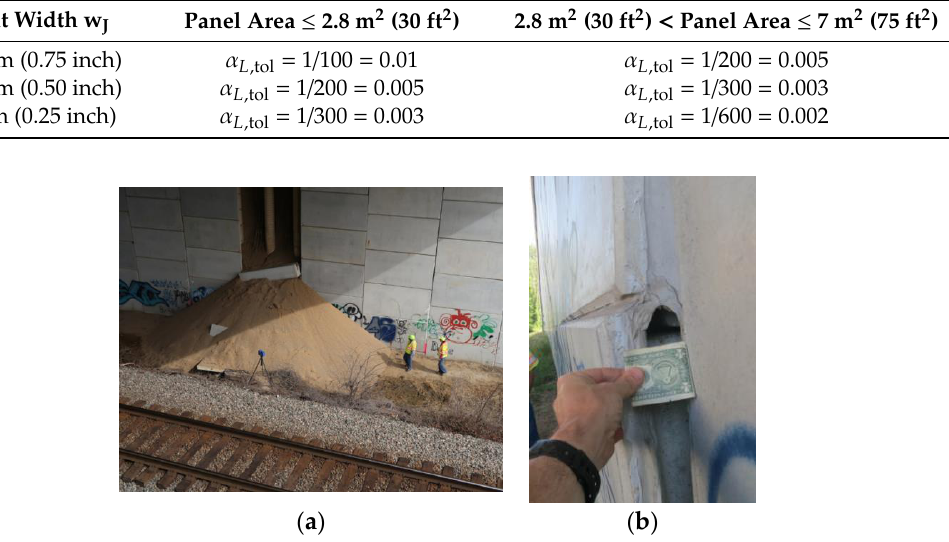
Figure 3. An example of ( a ) an MSE wall failure that started with ( b ) an excessive angular deformation (bulging) between neighboring panels.